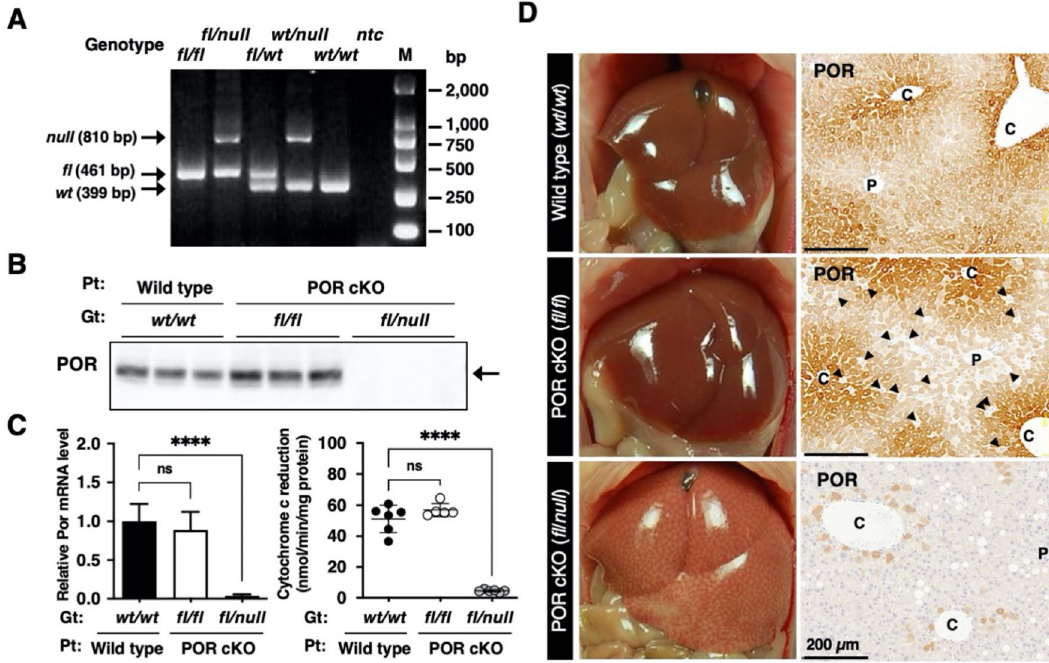
Figure 2. Generation of POR conditional knockout mice. ( A ) Representative PCR genotyping result for POR conditional knockout mouse. fl , floxed allele, wt , wild type, ntc , no template control. Full-length gel image was presented in Supplemental Fig. 6. ( B ) Western blot analysis of POR protein in liver microsomes from wildtype, POR cKO fl/fl , and POR cKO fl/null mice. Protein expression of mouse POR (arrow) assessed using immunoblotting with polyclonal antisera against POR. Gt, genotype, Pt, phenotype. Full-length blot image was presented in Supplemental Fig. 7. ( C ) Expression level of POR mRNA in the livers of wild-type mice (n = 6), POR cKO fl/fl (n = 9), and POR cKO fl/null mice (n = 6) were measured using qRT-PCR. The NADPH- cytochrome c reducing activity was determined to estimate POR activity in mouse liver microsomes. Data are presented as the mean ± SD. Statistically significant difference when compared with that in wild-type (TK-NOG) mice; ns, not significant, **** p < 0.0001. ( D ) Immunohistochemical staining of POR protein in livers from wild type, POR cKO fl/fl , and POR cKO fl/null mice. P, portal tract, C, central vein. Scale bar, 200 μm. Arrow-heads in POR cKO fl/fl panel indicate typical cells not express the POR